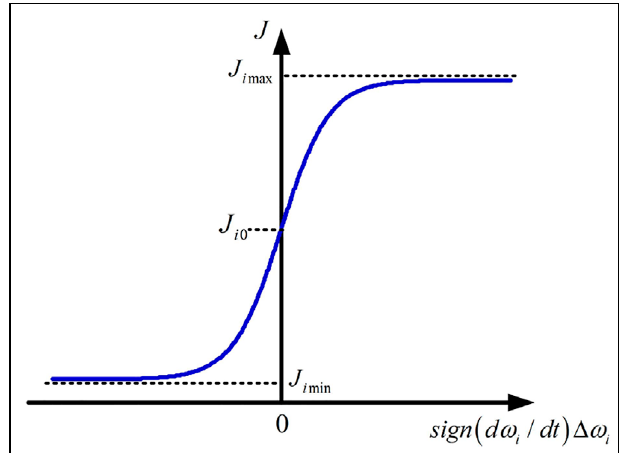
FIGURE 8 | Changing curve of virtual